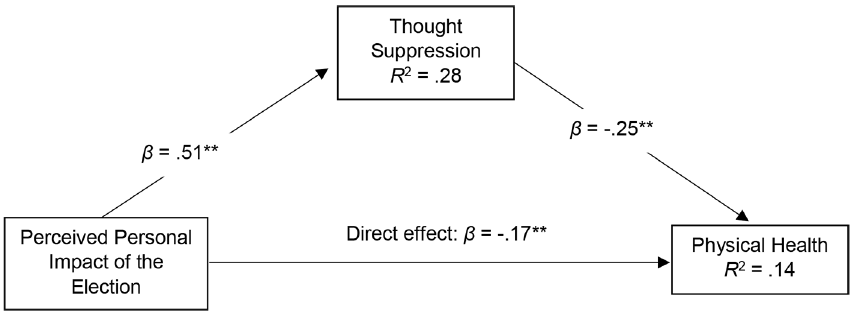
Figure 1. Perceived personal impact of the election predicting physical health. Note. Covariate = Age; n = 298. ** p < .01. Total effect: β = -.30, p <